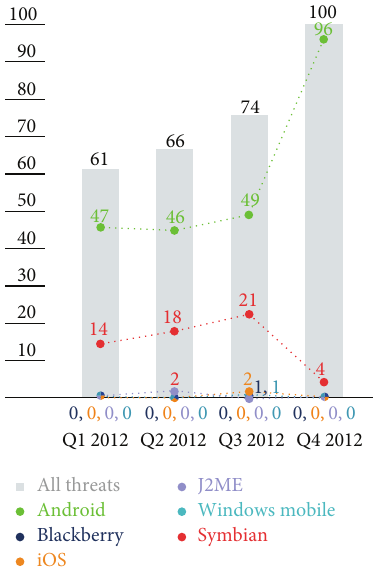
Figure 1: Increase of Android